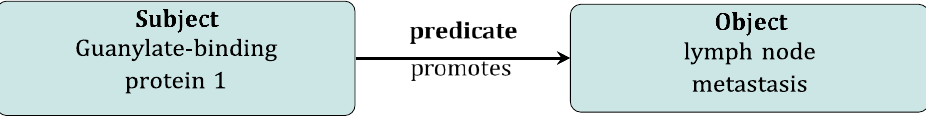
“ GENE Guanylate-binding protein 1 (GBP1) promotes PHENOTYPE lymph node metas- tasis in human DISEASE esophageal squamous cell carcinoma. ” Assuming the following recognized entities: “ Guanylate-binding protein 1 ” as